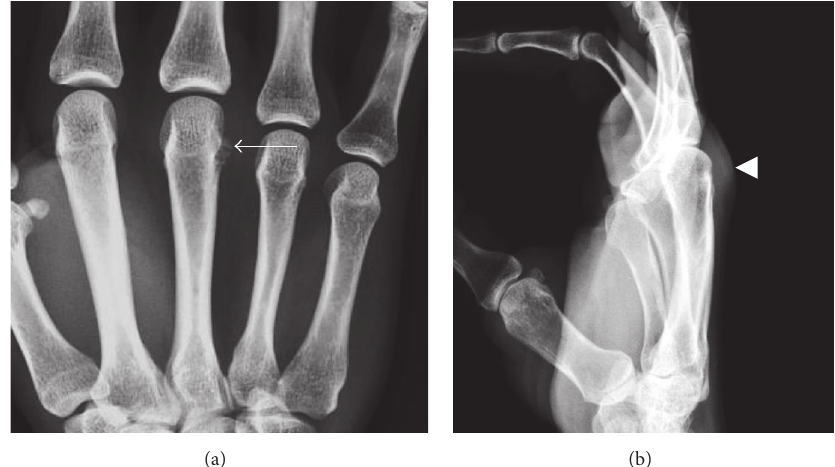
Figure 11: Calcific periarthritis of the third metacarpophalangeal joint. (a) Small amorphous capsular calcifications are present along the ulnar aspect of the third metacarpal neck (arrow). (b) Associated soft tissue swelling of the third metacarpophalangeal joint is present, best appreciated on a lateral view